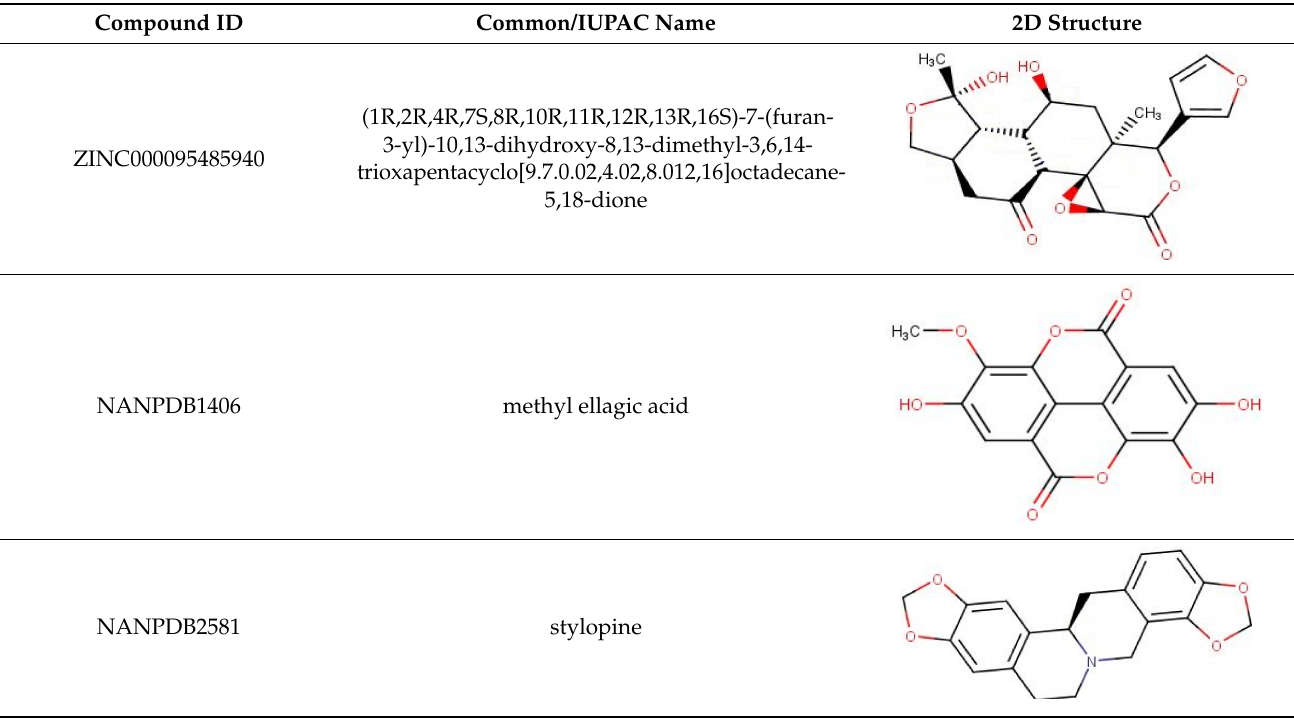
Table 10. Selected compounds and known Ld CRK12 inhibitors with their two-dimensional (2D) structures and common names or International Union of Pure and Applied Chemistry (IUPAC) names. The IUPAC names were generated using the Marvin suite (http://www.chemaxon.com/; accessed on 27 February 2020).